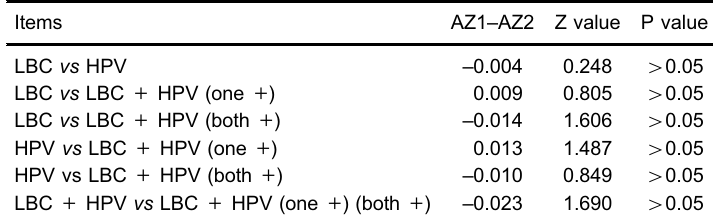
Table 3. Comparison of the area under ROC